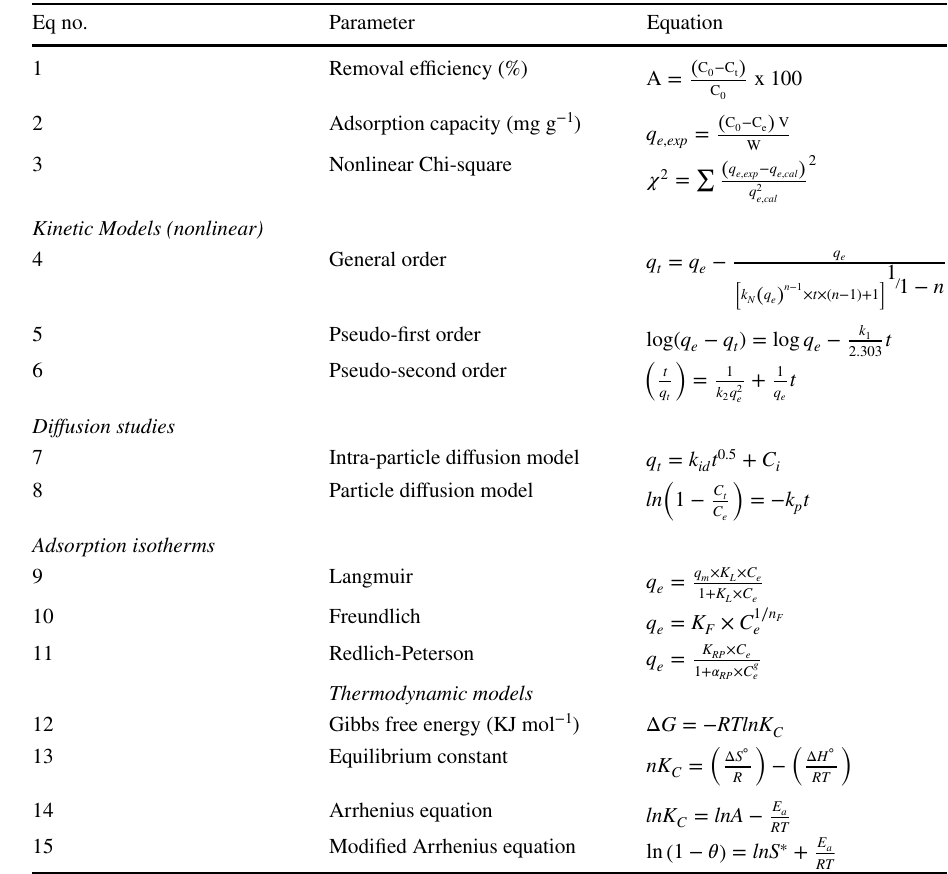
Table 2 Different theoretical model equations used for adsorption studies